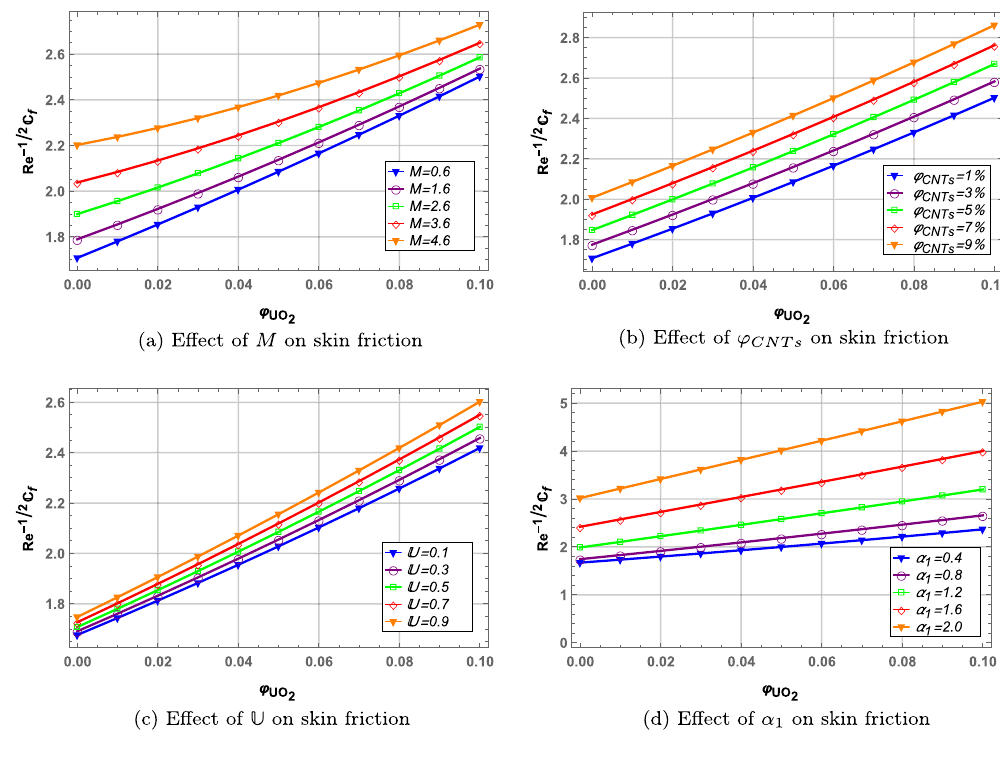
Figure 10. Skin friction profile.